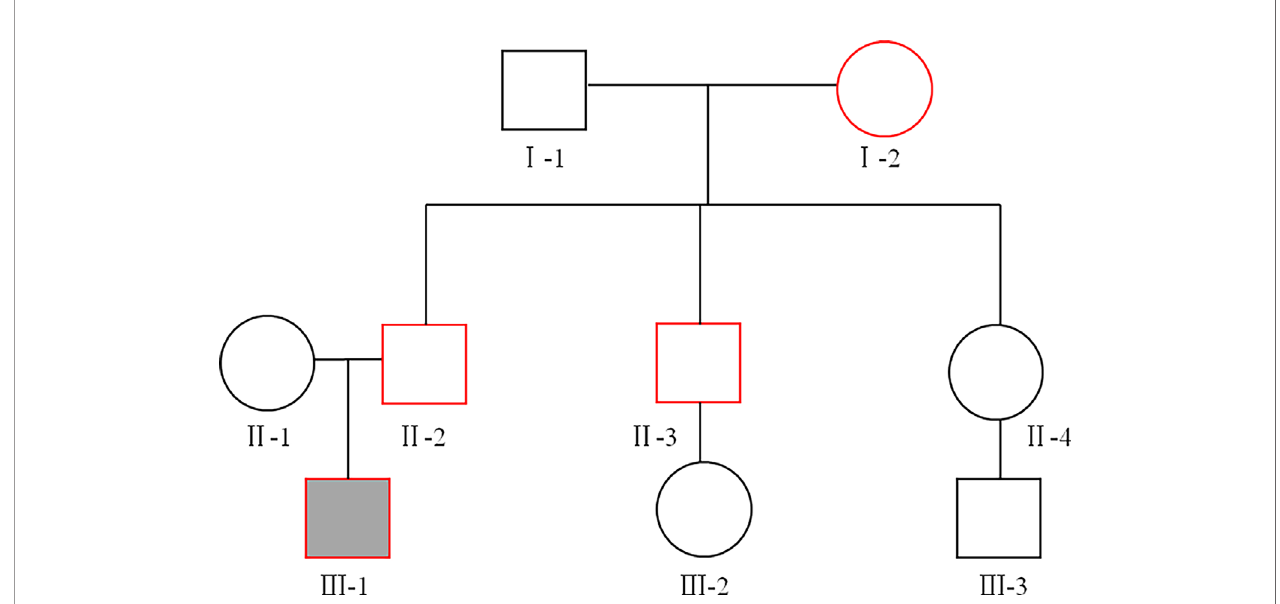
FIGURE 1 | The family pedigree. Squares represent males, circles represent females. The proband is represented by a solid black box, and the red line indicates patients with diabetes. The proband (III-1), his father (II-2), his uncle (II-3), and his grandmother (I-2) were diagnosed with type 2 diabetes (T2D) at the age of 18, 42, 43, and 60,